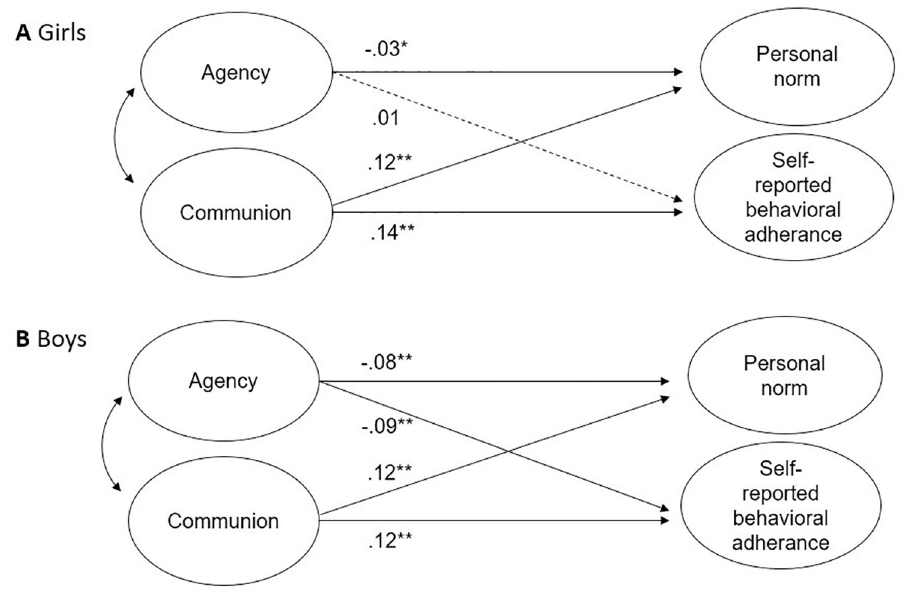
Fig 2. Structural equation model predicting personal norm and self-reported behavioral adherence to COVID measures in male and female sub-sample (Model 2). This SEM predicts personal norm and self-reported behavioral adherence to COVID measures from girls’ (panel A) and boys’ (panel B) agentic and communal orientation. Statistics are standardized regression coefficients. Dotted lines represent non-significant relations. � p < .05 �� p < .001.